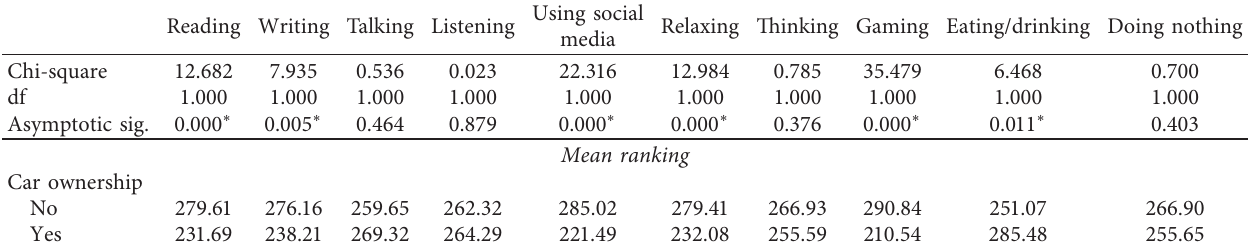
Table 15: Kruskal–Wallis test statistics and the rankings of car ownership groups.